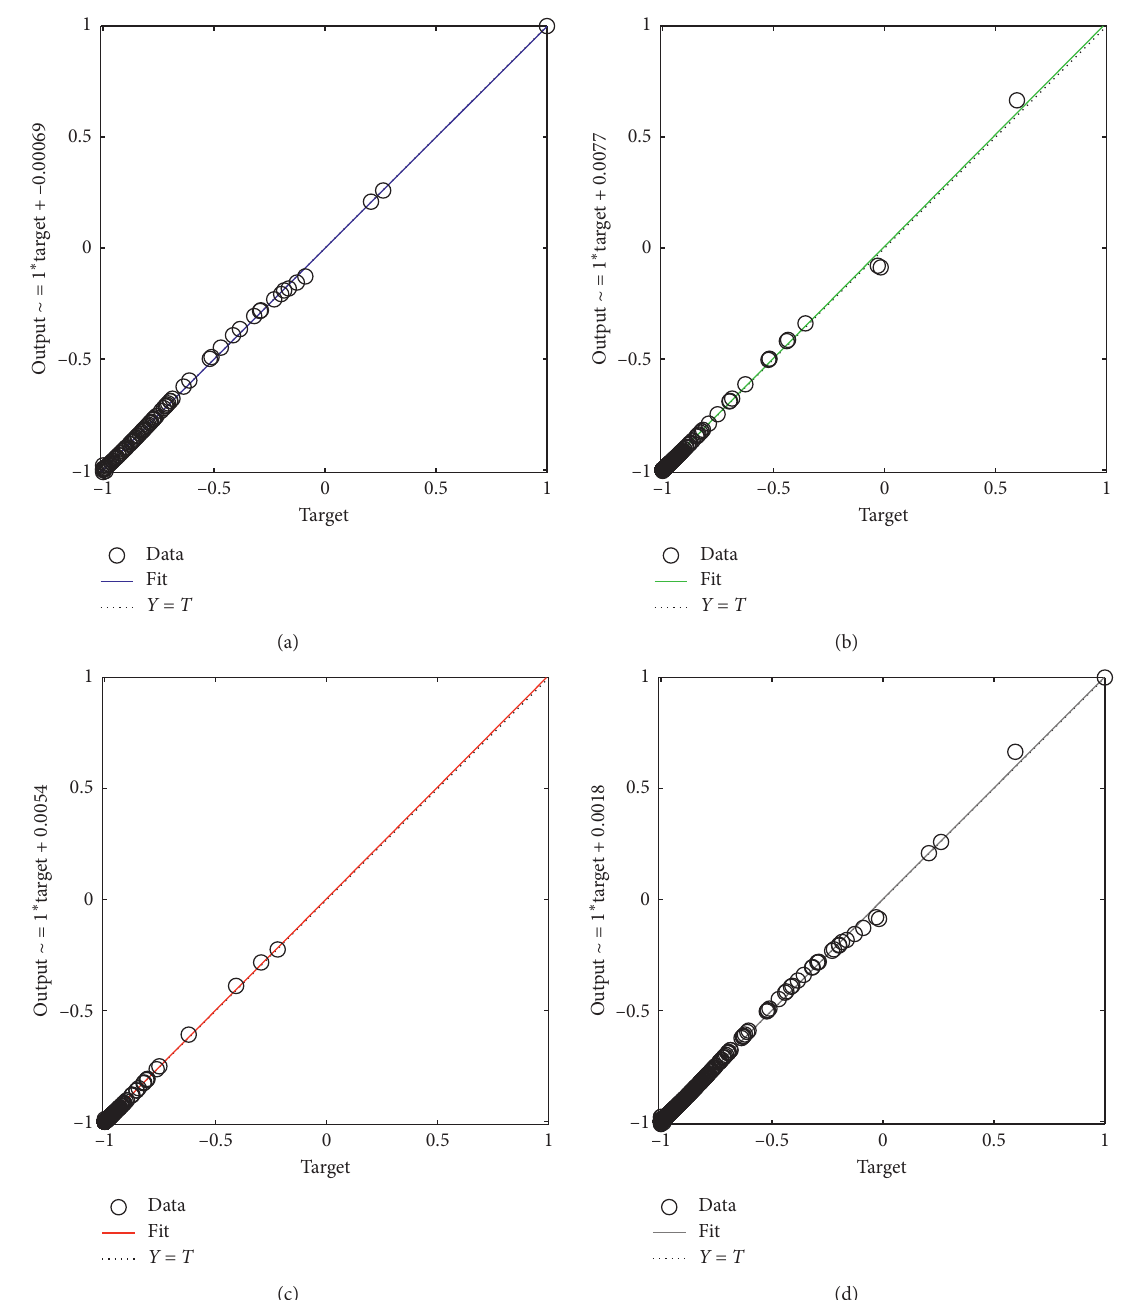
Figure 5: Overall goodness of the fit diagram: (a) training: R � 0.99972; (b) validation: R � 0.99897; (c) test: R � 0.99967; (d) all: R �